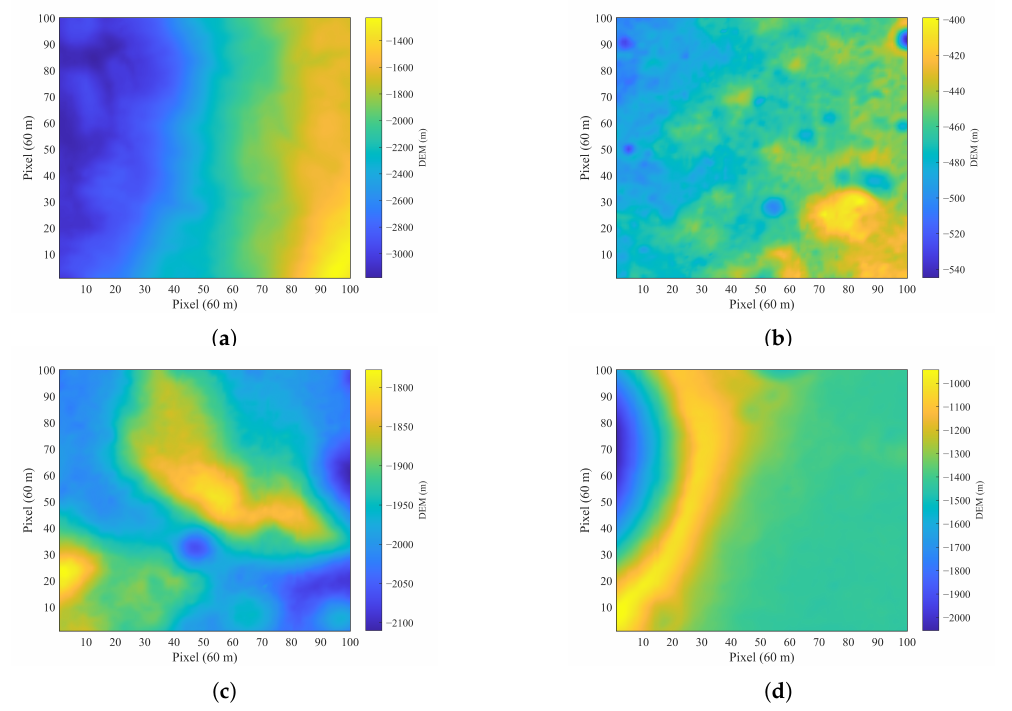
Figure 8. Four arbitrarily selected regions on the lunar surface: ( a ) Area A: (23.7 ◦ N, 47 ◦ W), ( b ) Area B: (10 ◦ S, 0 ◦ E), ( c ) Area C: (20 ◦ N, 10 ◦ E), and ( d ) Area D: (16 ◦ N, 26 ◦ W). The DEM has a spatial resolution of 60 m in every